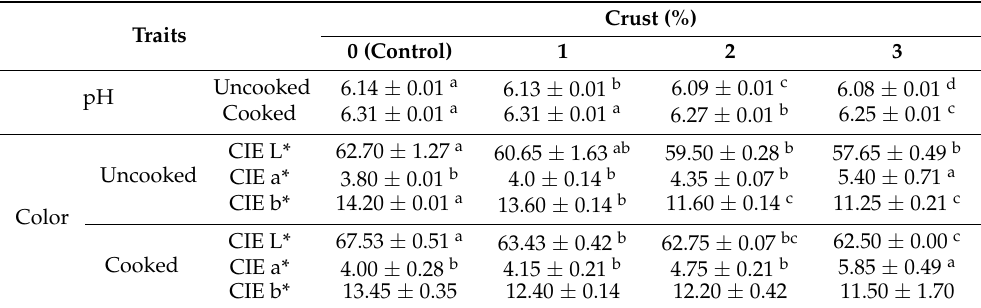
Table 3. pH and color of pork patties formulated with various levels of crust derived from dry-aged beef